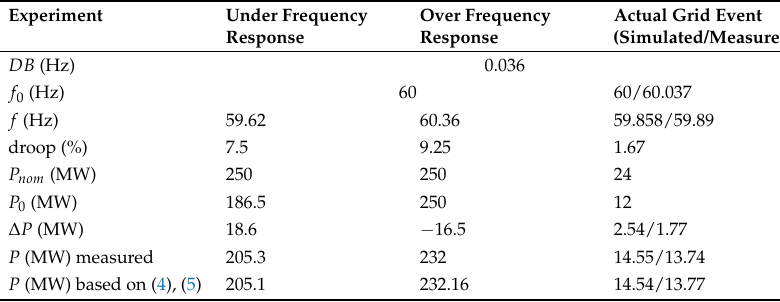
Table 4. Power change calculations for frequency